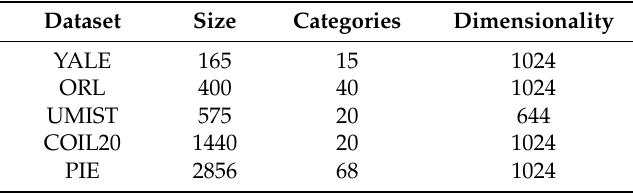
Table 1. Statistics of the datasets.